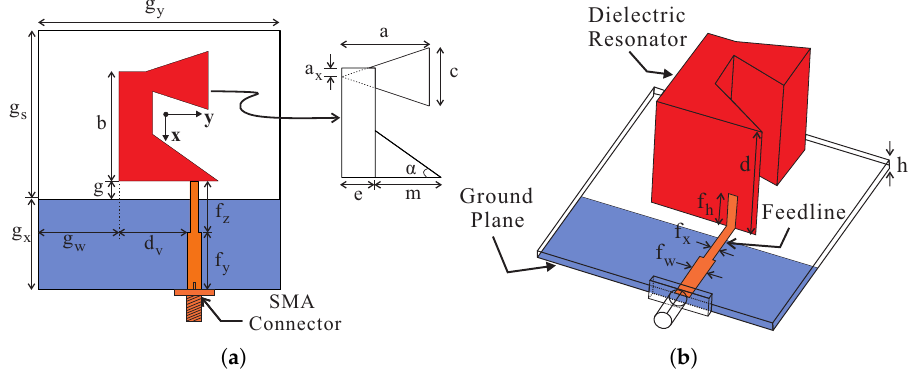
Figure 1. Geometry of the proposed antenna: ( a ) top view; ( b ) panoramic view. SMA: SubMiniature version